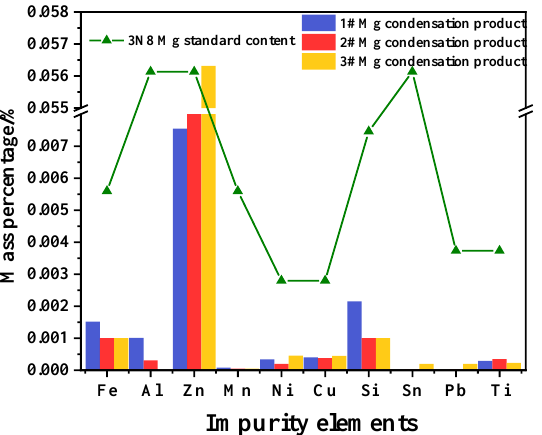
Figure 8. Axial temperature and condensation mass fraction as a function of axial distance (P = 100 Pa; T0 = 1073 K; T1 = 873 K; t = 30 min).